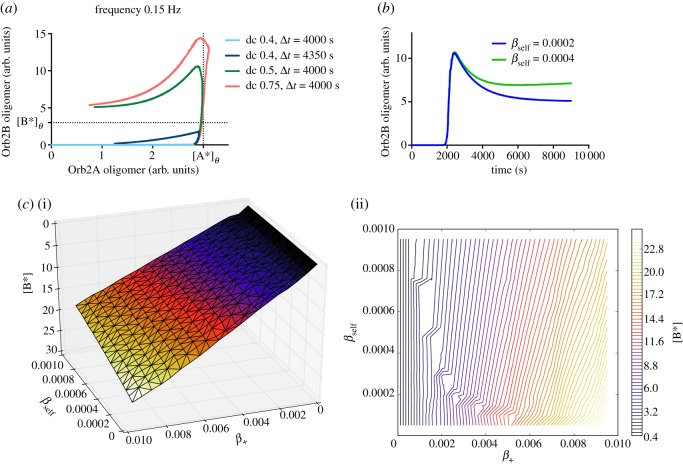
Role of different parameters of the model in the final aggregation outcome. (a) The presence of steep sigmoidal functions implies that the formation of a stable Orb2B aggregate depends on reaching the threshold size for the Orb2A aggregate [A*]theta; and the self-templating threshold size for the Orb2B aggregate [B*]theta;. (b) The size of the mature Orb2 aggregate at the steady state depends on the ability of the aggregate to self-template new monomers, which in the model is described by βself. (c) Relationship between the size of the steady-state Orb2B aggregate ([B*]) and the dynamics of synaptic Orb2B, in particular, related to the parameters β+ and βself, visualized with a surface (c(i)) or a contour plot (c(ii)).